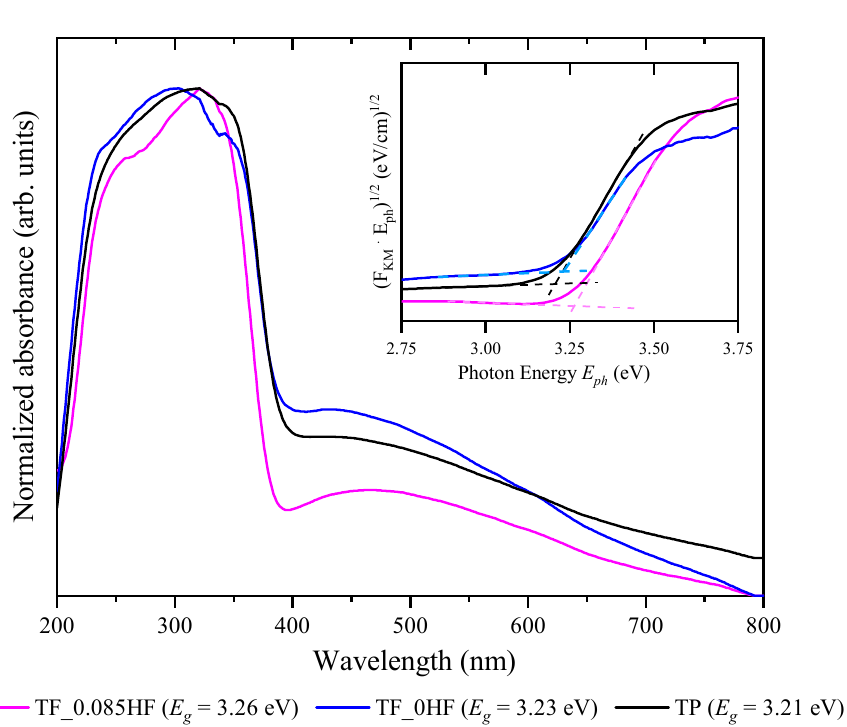
Figure 2. SEM images of as-prepared samples.